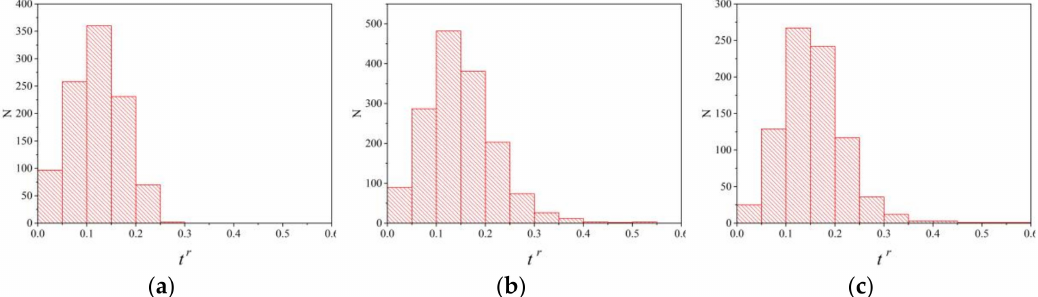
Figure 9. Histogram of the number of dimples with different levels of relative depth t r VT23 under static deformation ( a ), DNP1 ( b ), and DNP2 ( c